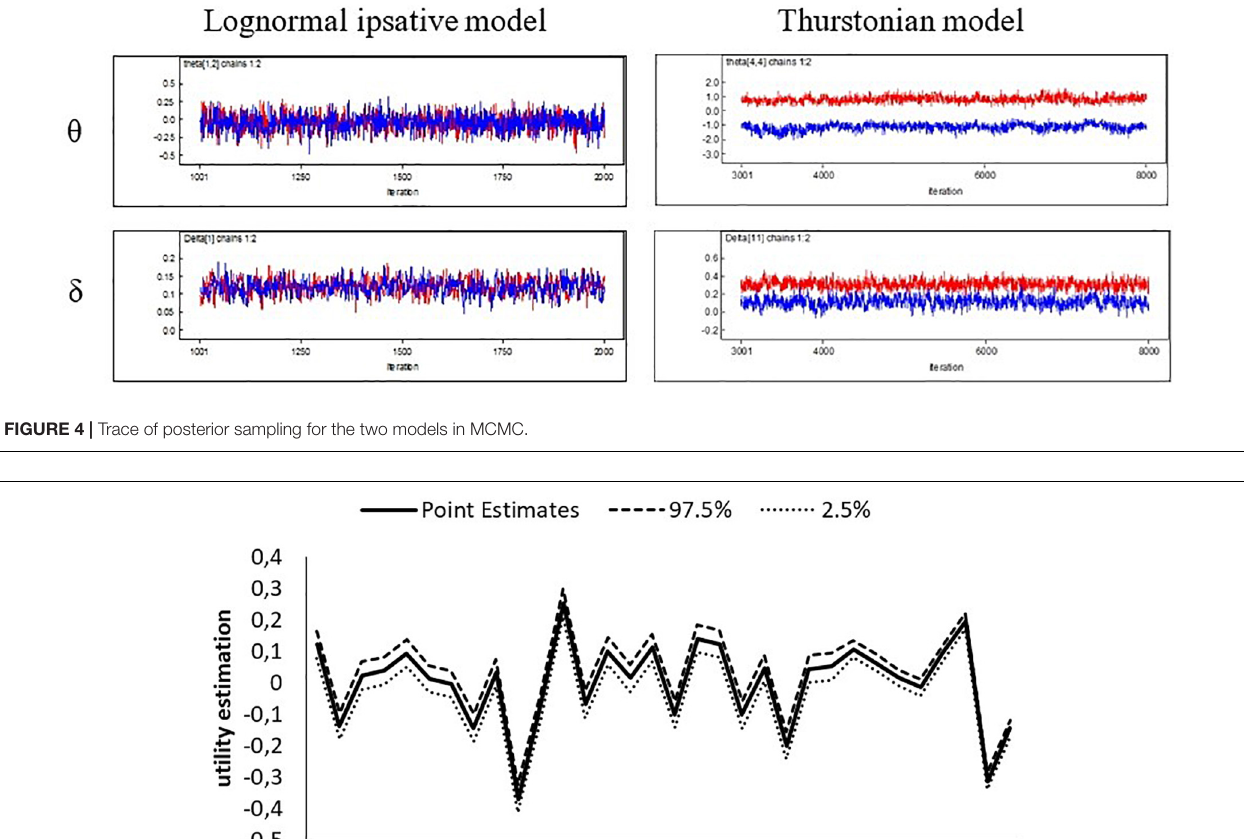
traits θ = [ − 0.08, 0.16, − 0.21, 0.13]. Although he/she values Conservation the highest (0.16) and Self-Enhancement the lowest ( − 0.21), both latent traits are close to zero (the range